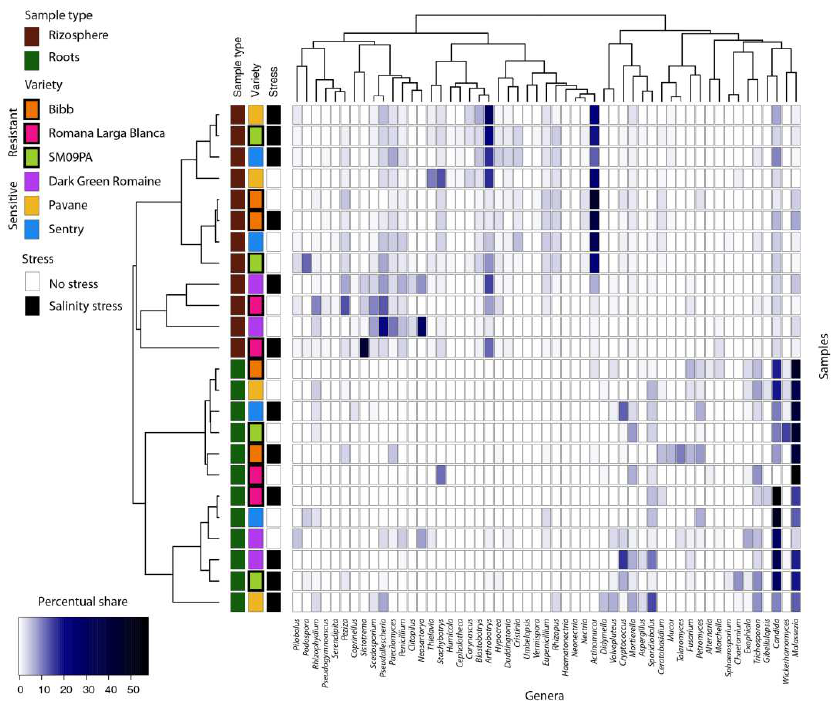
Figure 7. Heatmap of the most common fungal genera in samples from lettuce roots and rhizosphere. Only genera with min. 3% occurrences in any samples are listed. Dendrograms are based on occurrence of genera in samples (Bray–Curtis distance, complete clustering).